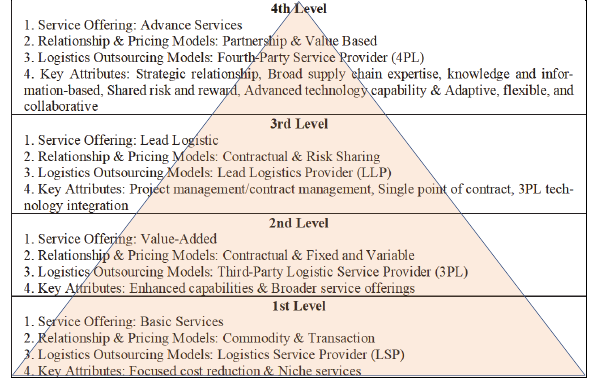
Fig. 1. Logistic Services Provider Level (Adapted from Langley et al.,